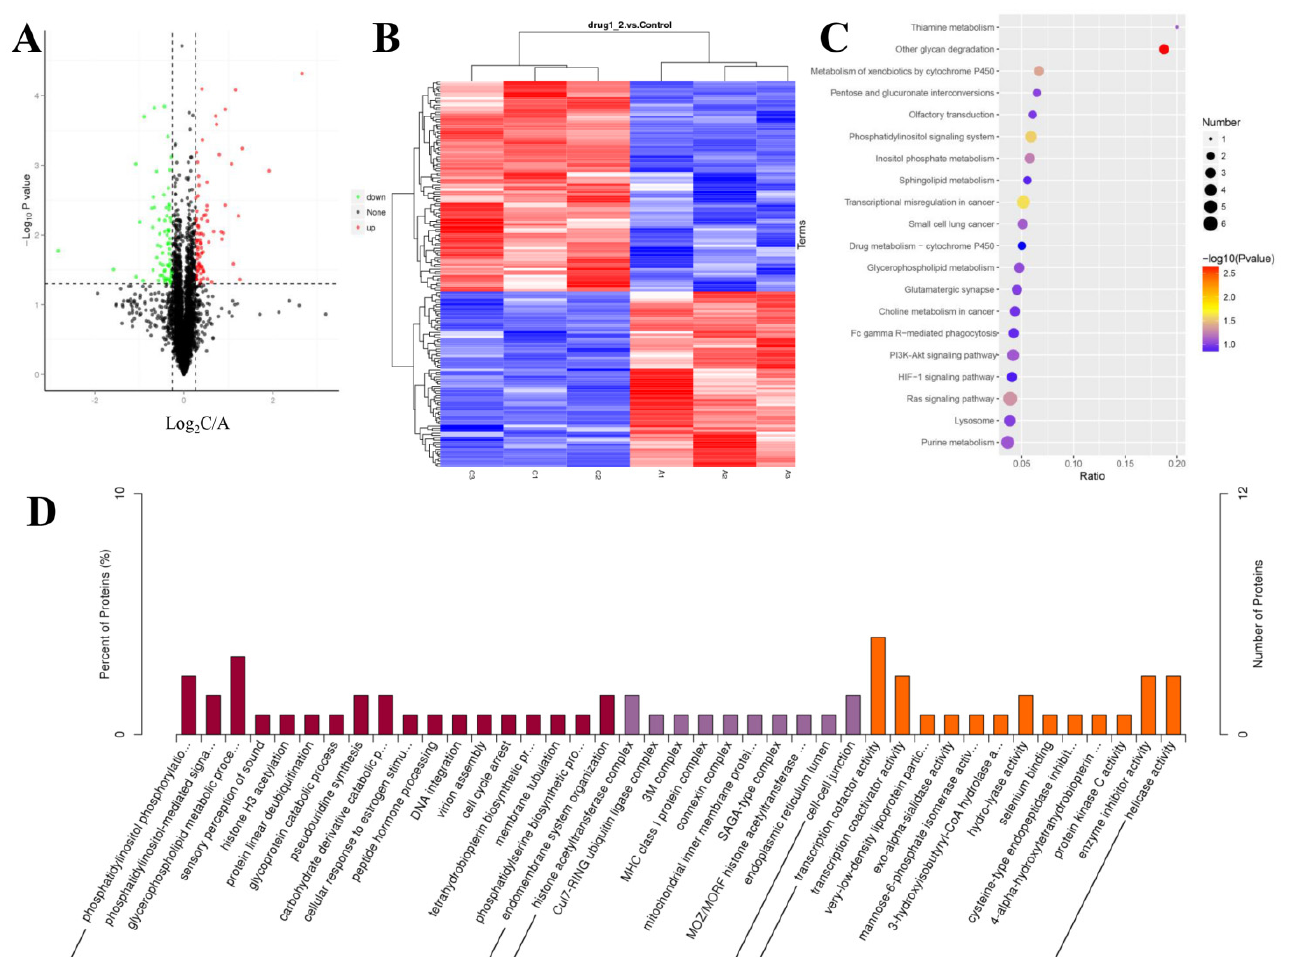
Figure 4. Characteristics of the identified proteins in PC12 cells with or without GDF11-treated. ( A ) Volcano plot of the 165 differentially expressed proteins in GDF11-treated group when compared to GDF11-untreated group. A protein with a fold change > ±1.2 and p < 0.05 was regarded as a differentially expressed (up-regulated or down-regulated) protein, which was colored in red or green, respectively. The identified proteins with no significant changes were in black. ( B ) Hierarchical clustering heat map of the 165 differentially expressed proteins. A1, A2, and A3 represented the 3 replicates of the GDF11-untreated group, and C1, C2, and C3 represented the 3 replicates of GDF11-treated PC12 cells. ( C ) The top 20 enrichment KEGG pathway of the differentially expressed proteins. ( D ) GO enrichment analysis of the DEPs in three categories, i.e., molecular function, cellular component, and biological process.